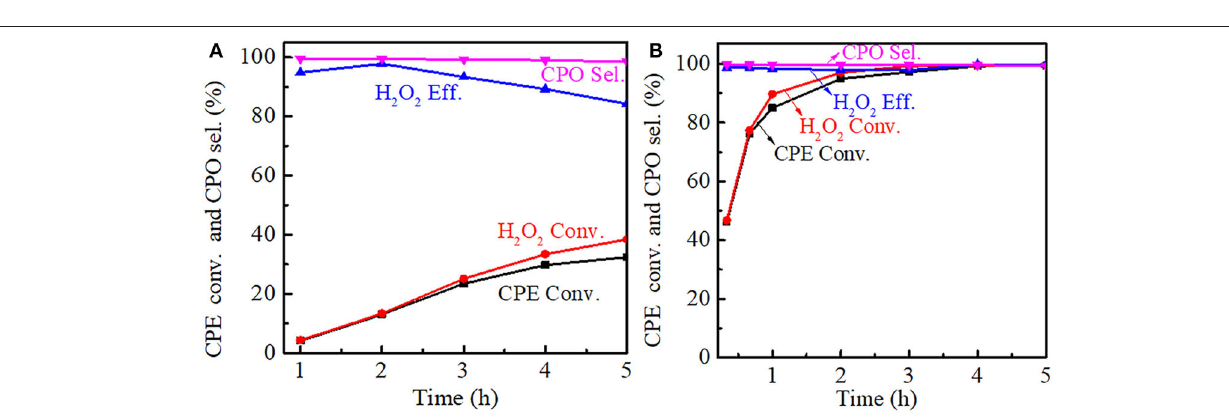
FIGURE 9 | Dependence of CPE conversion, H 2 O 2 conversion, H 2 O 2 efficiency, and CPO selectivity on the reaction time over Ti-MWW (A) and R-Ti-MWW-PI (B) . Reaction conditions: catalyst, 50mg; CPE, 10 mmol; H 2 O 2 (30 wt.%), 10 mmol; MeCN, 10mL; temp., 333K.